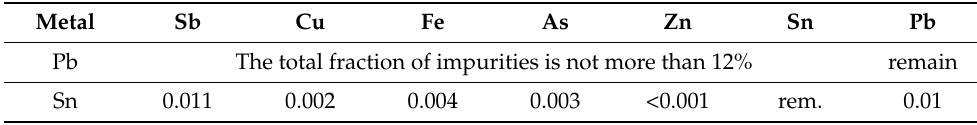
Table 3. The composition of the coating flux (wt.%). KCl NaCl NaF Na 3 AlF 6